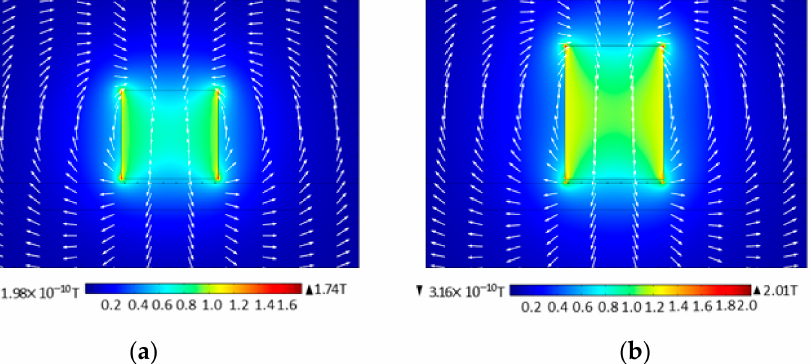
Figure 10. Flux density mode of static magnetic field before and after applying ANSM. ( a ) Before adding ANSM and ( b ) after adding ANSM.